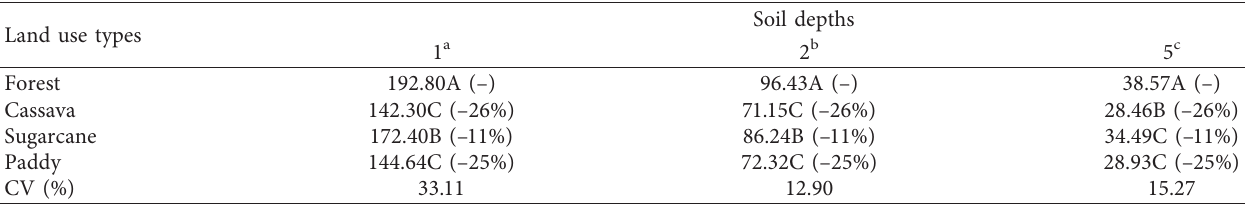
Table 6: Means for soil organic matter content (Mg · ha –1 ) in soil profiles averaged from four land use types and six